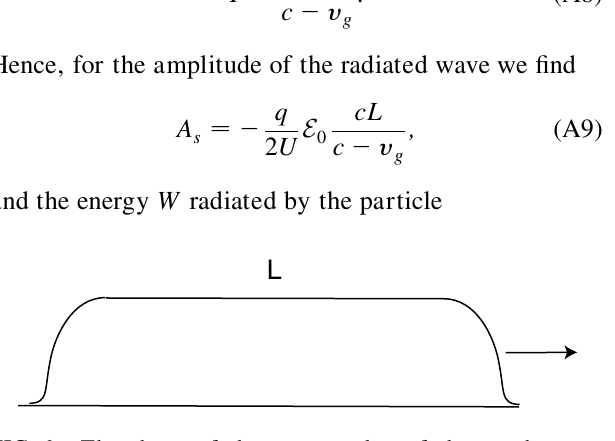
FIG. 6. The shape of the wave packet of the synchronous mode. The packet has a long plateau of length L and short